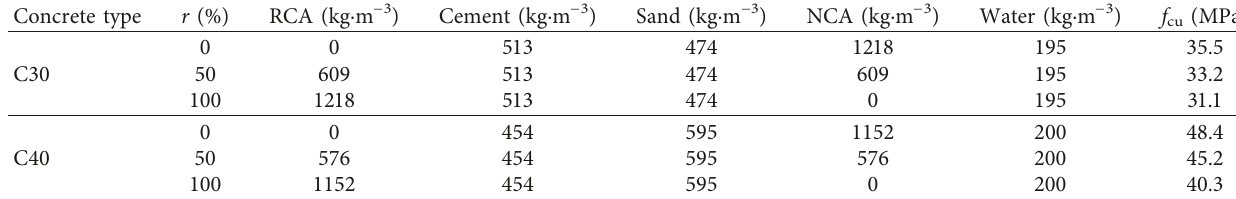
Table 2: Mix proportion of the recycled coarse aggregate concrete.